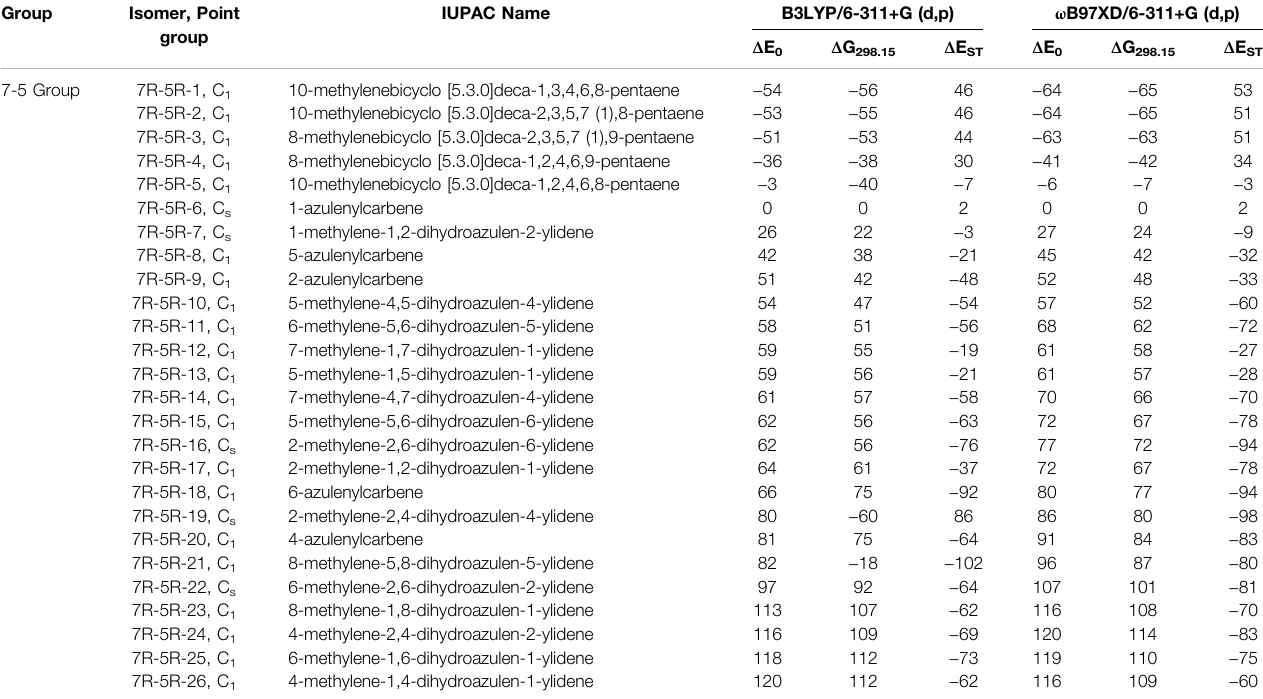
TABLE 2 | Same as Table 1 , low-lying C 11 H 8 carbene isomer of (7R-5R) group calculated at different levels. Group Isomer, Point